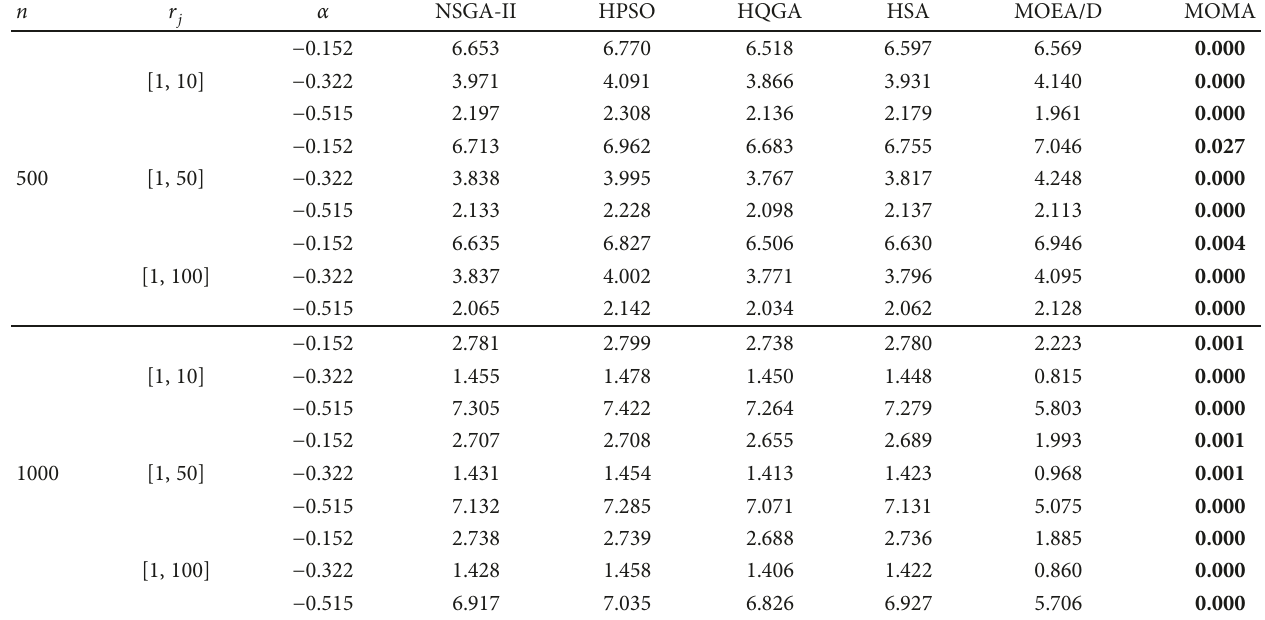
Table 4: The mean IGD value ( × 10 6 ) of 6 algorithms.